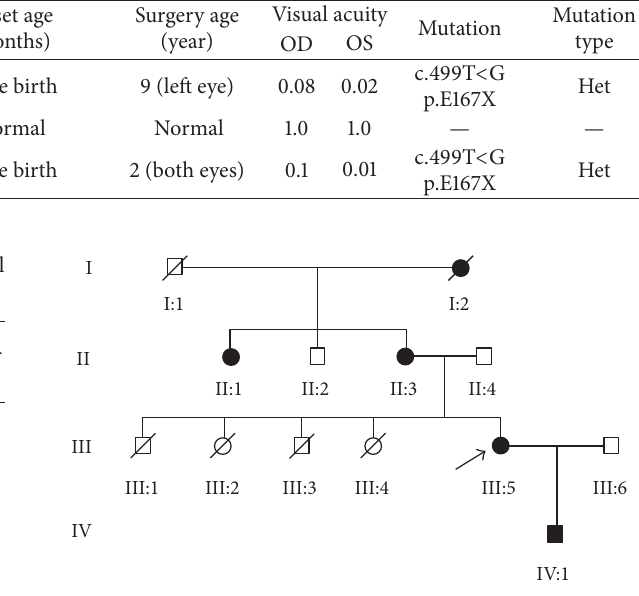
Figure 1: Pedigree of the Chinese family with congenital cataract. Squares and circles symbolize males and females, respectively. Clear and blackened symbols denote unaffected and affected